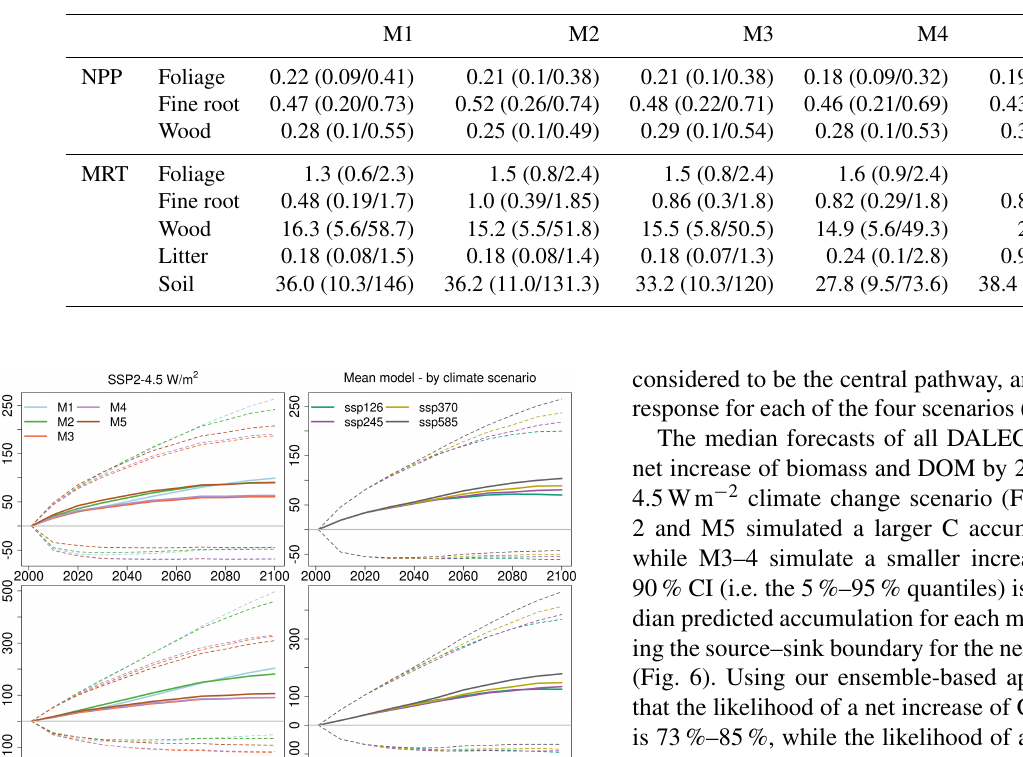
Table 3. Mean Brazilian C-cycle NPP allocation fractions and MRTs (years) calculated with five different model structures (M1–5). The Brazil-wide mean is calculated from the median pixel-level estimates, with the equivalent estimates for the 5% and 95% quantiles in parentheses denoting the 90% confidence interval. Note that litter in M5 includes the additional wood litter pool.